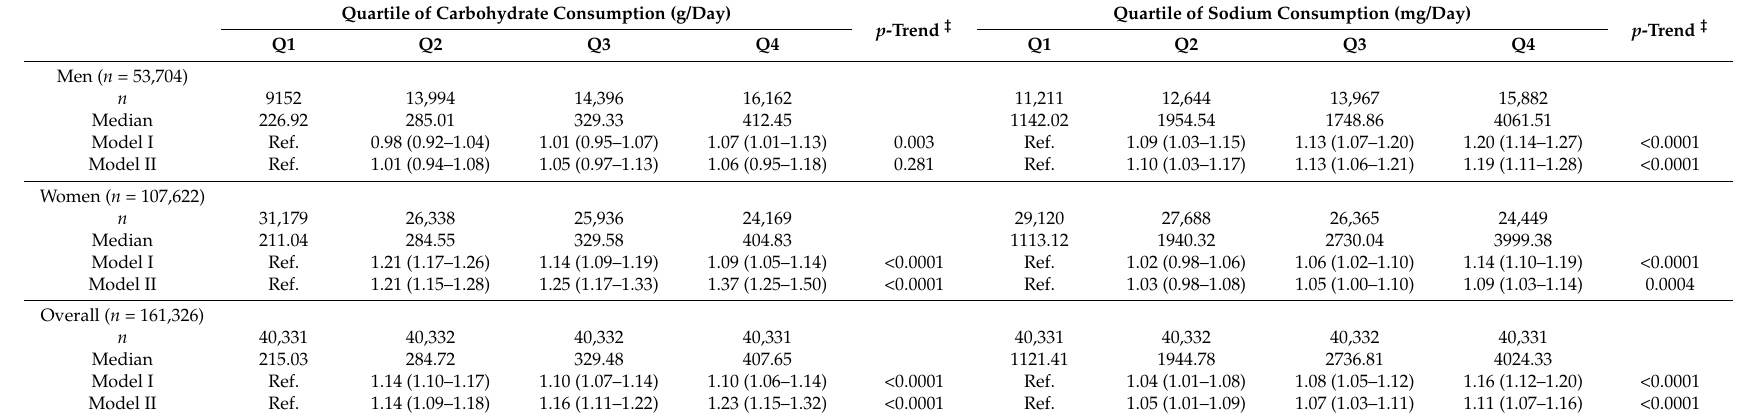
Quartile of Sodium Consumption (mg/Day) p -Trend ‡